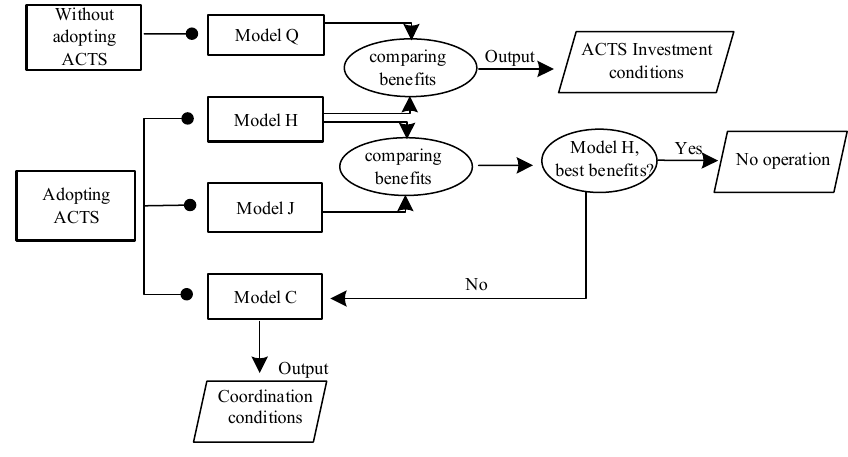
Figure 5. Research idea map.